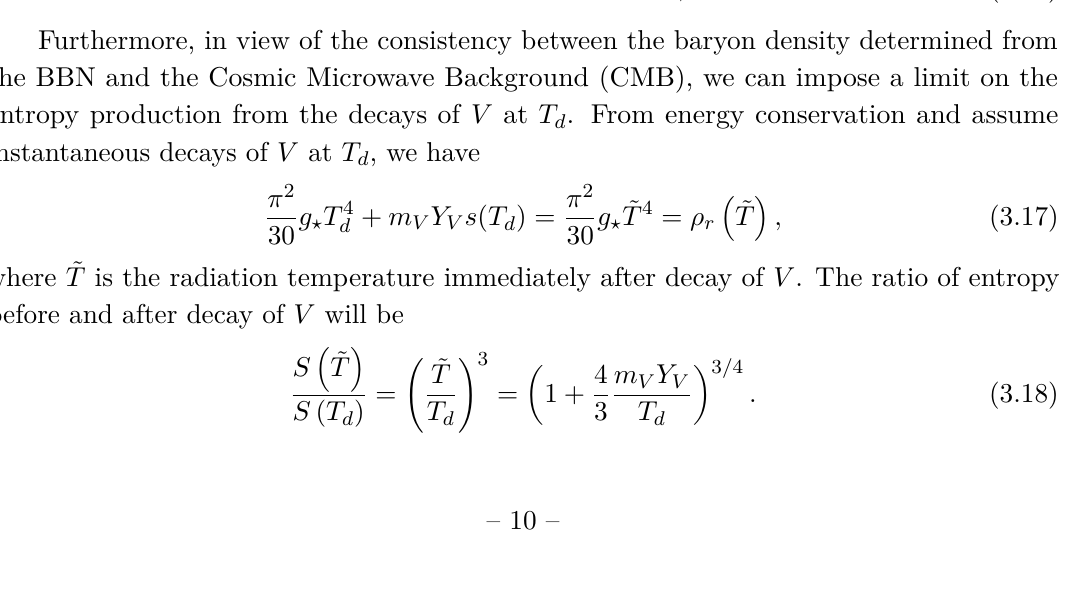
Figure 2 . The upper bound on the Hubble rate after inflation H max boson mass m . The upper (lower) region corresponds to r V upper (lower) boundary of the regions correspond to κ = 1 ( κ = 10